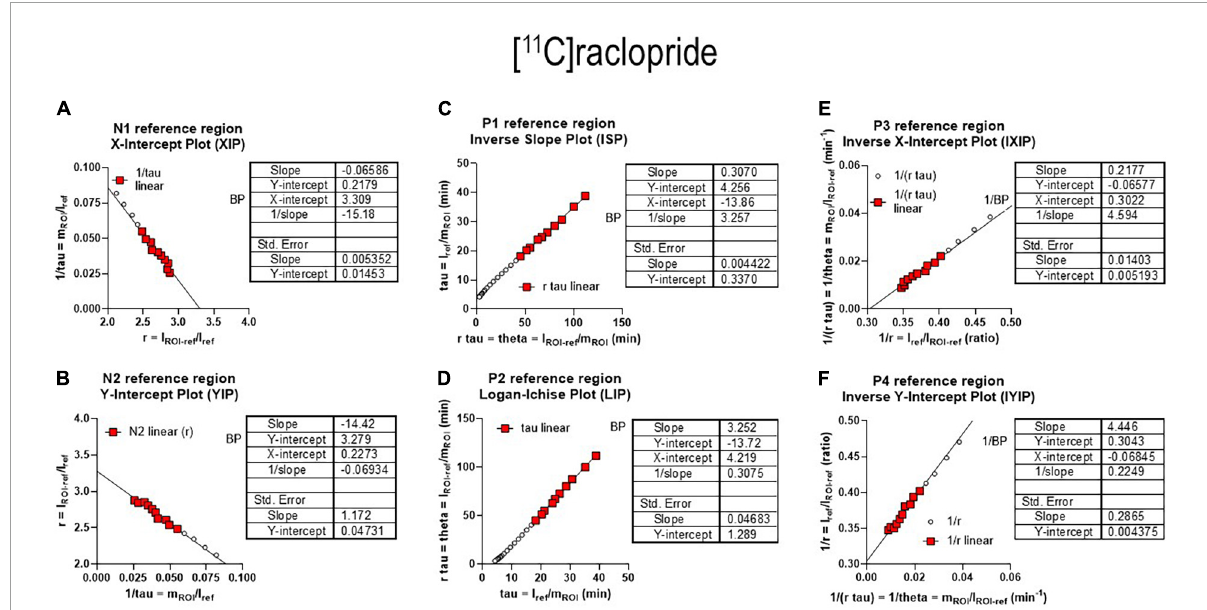
FIGURE10 Receptor binding relative to non-binding reference region. (A) Left graph reference region N1 graphical plot. (B) Right graph reference N2 graphical plot. (C) Left graph reference region P1 plot. (D) Right graph reference region P2 plot, equivalent to Logan reference region plot. (E) Left graph reference region P3 plot. (F) Right graph reference region P4 plot (adapted from Gjedde, 2003 and Zhou et al.,